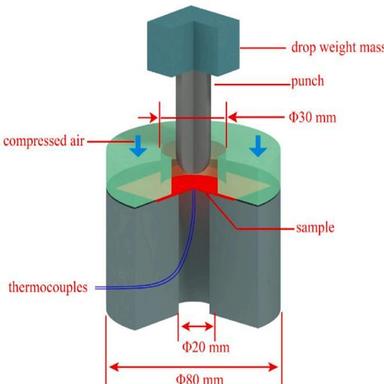
Schematic drawing of sample fixture and punch sectioned by a quarter.